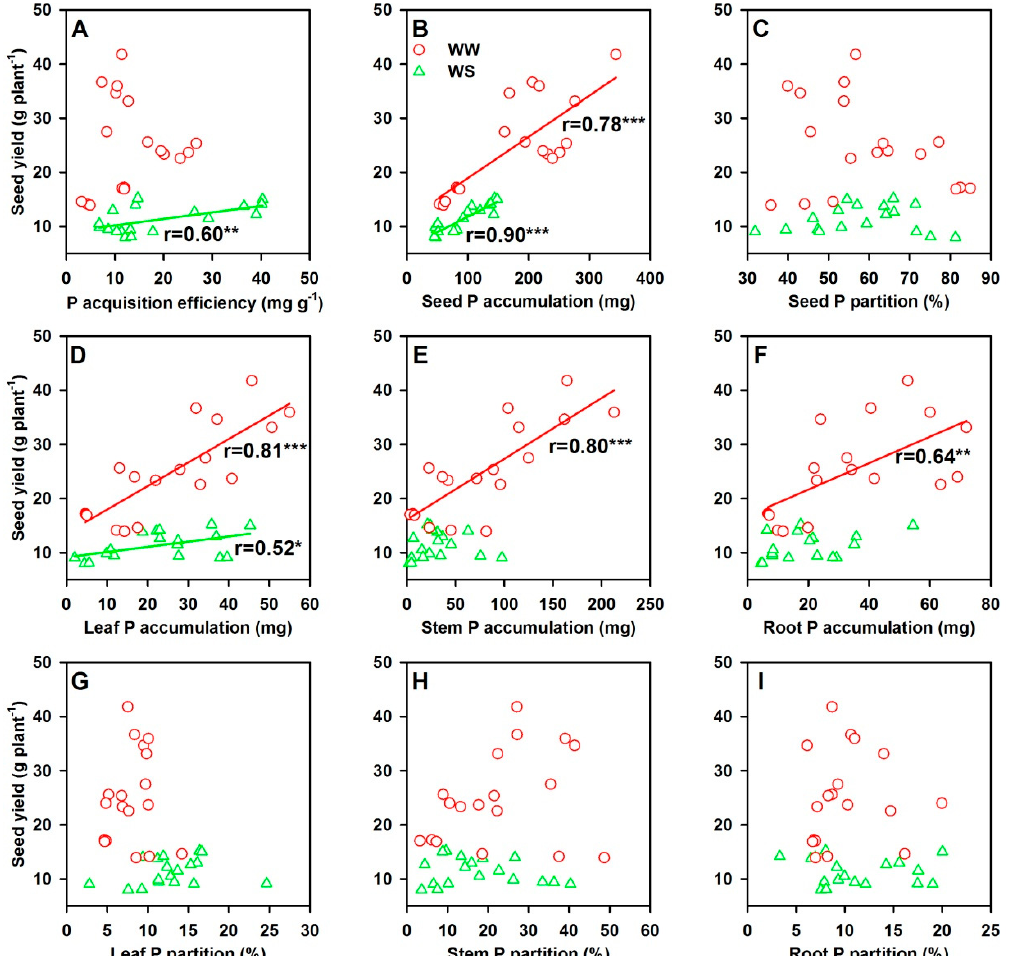
Figure 6. The relationship between the seed yield and P acquisition efficiency ( A ), seed P acquisition ( B ) and partition ( C ), leaf P acquisition ( D ) and partition ( G ), stem P acquisition ( E ) and partition ( H ), root P acquisition ( F ) and partition ( I ) under two water regimes (well-watered (WW) and cyclic water stress (WS)) and three P rates (0 (P0), 60 (P60), and 120 (P120) mg P kg –1 dry soil). p < 0.05, * p < 0.01, *** p < 0.001.